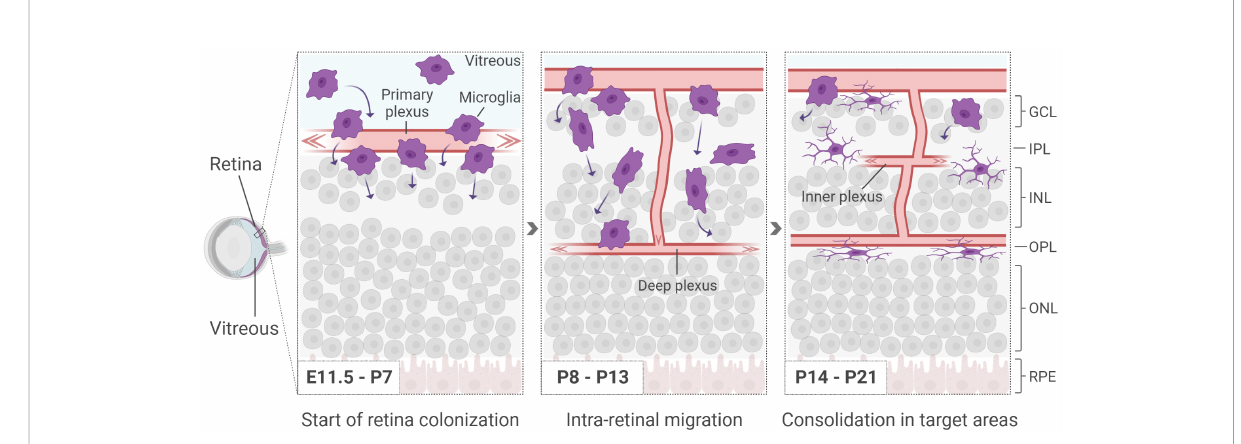
FIGURE 1 Microglia start appearing in the retina around E11.5, before the formation of the inner vasculature. At early postnatal days, as the deeper vasculature plexus develop, microglia in fi ltrate the retina in a radial manner, colonizing fi rst the IPL and subsequently the OPL. Retinal cells are shown simpli fi ed. GCL, ganglion cell layer; IPL, inner plexiform layer; INL, inner nuclear layer; OPL, outer plexiform layer; ONL, outer nuclear layer; RPE, retinal pigmented